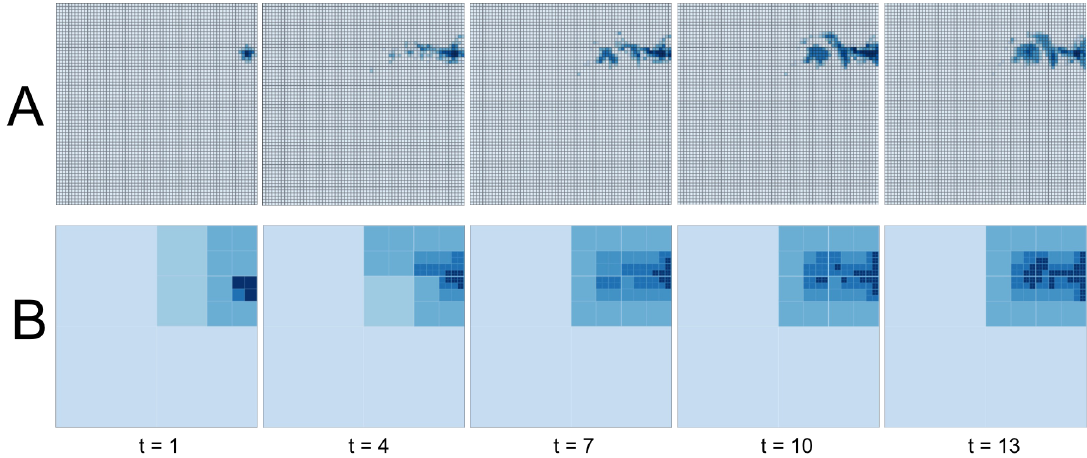
Figure 9. Timeline of flooding using ( A ) regular grids, ( B ) adaptive